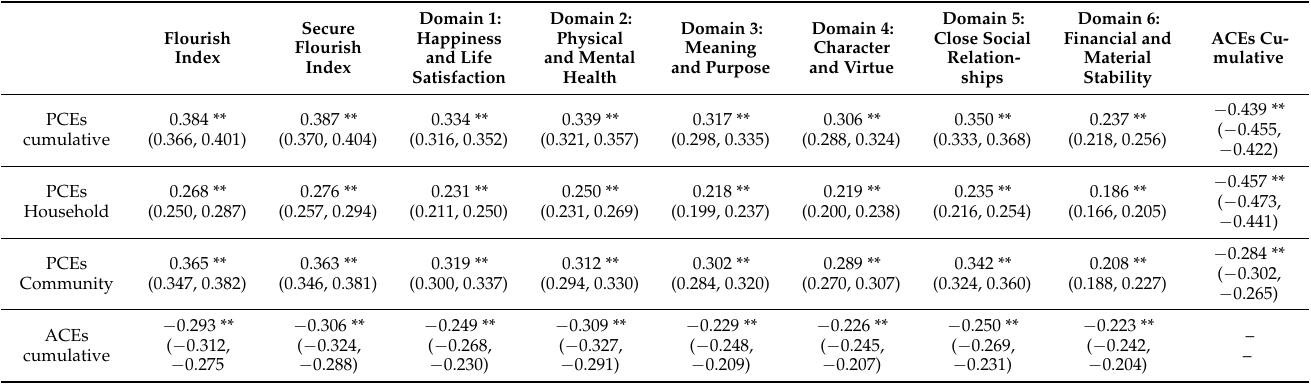
Table 3. Correlations between the cumulative and subdimension scores of the 9-item PCEs, cumula- tive ACEs, and adult flourishing indices and domains (all p -value < 0.001).